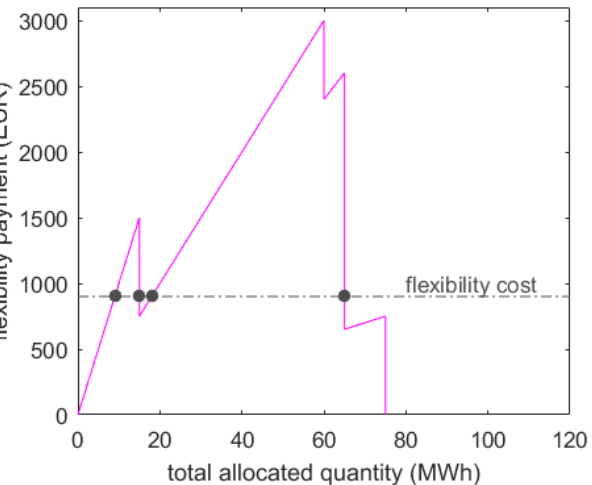
Figure 4. The summarized flexibility payment is a function of the total allocated quantity in the clearing example.